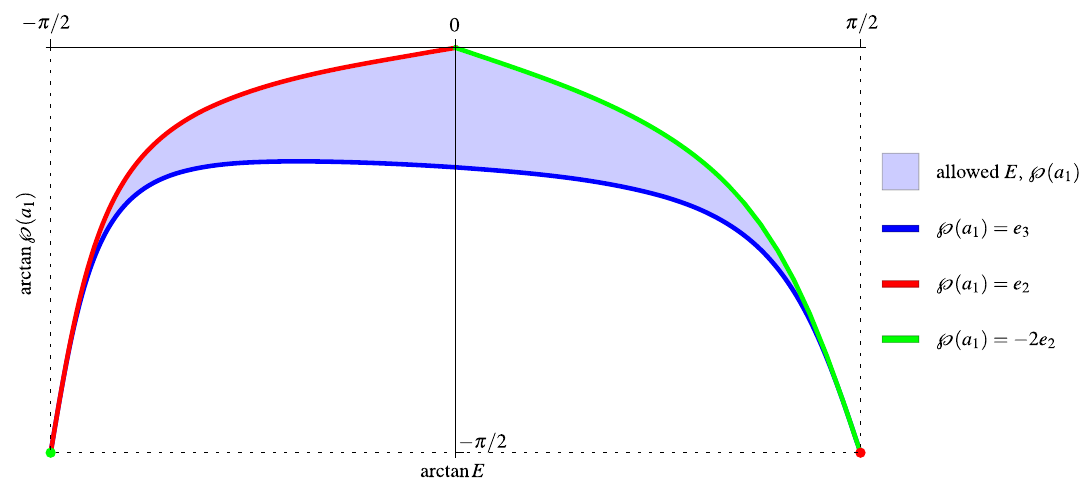
Fig. 3 The parameter space of elliptic minimal surface